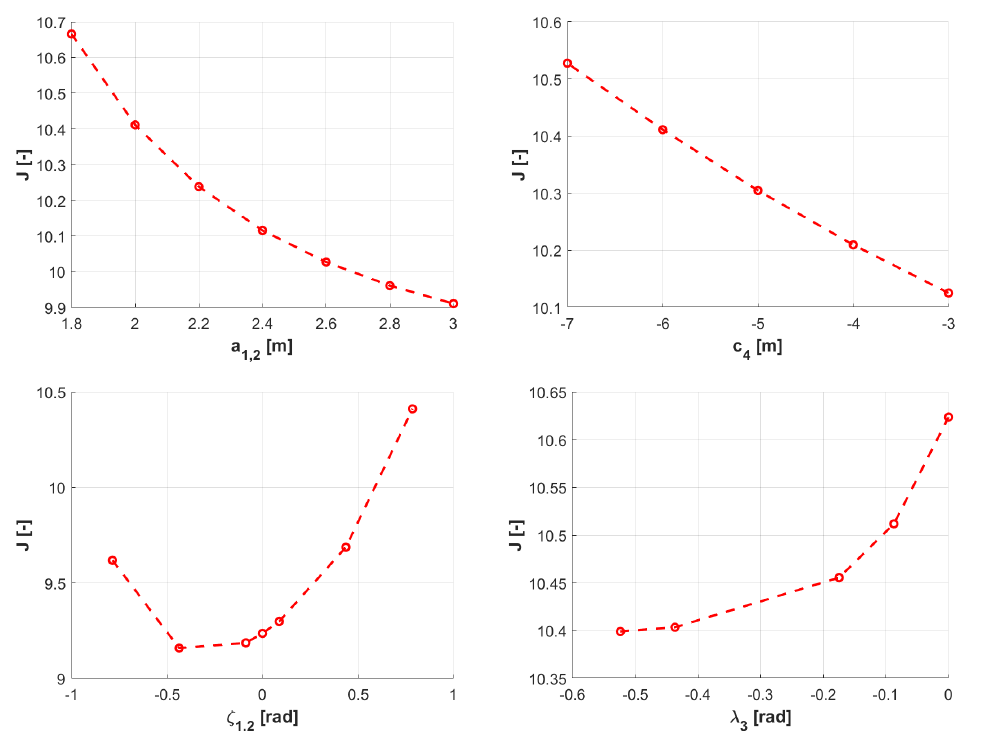
Figure 9. Example studies on the sensitivity of the cost function with respect to parameters a 1,2 , c 4 , ζ 1,2 , and λ 3 for layout (B). Trim speed 12 m/s. Computation of the cost function based on N s = 18 sim- ulations corresponding to as many perturbed initial